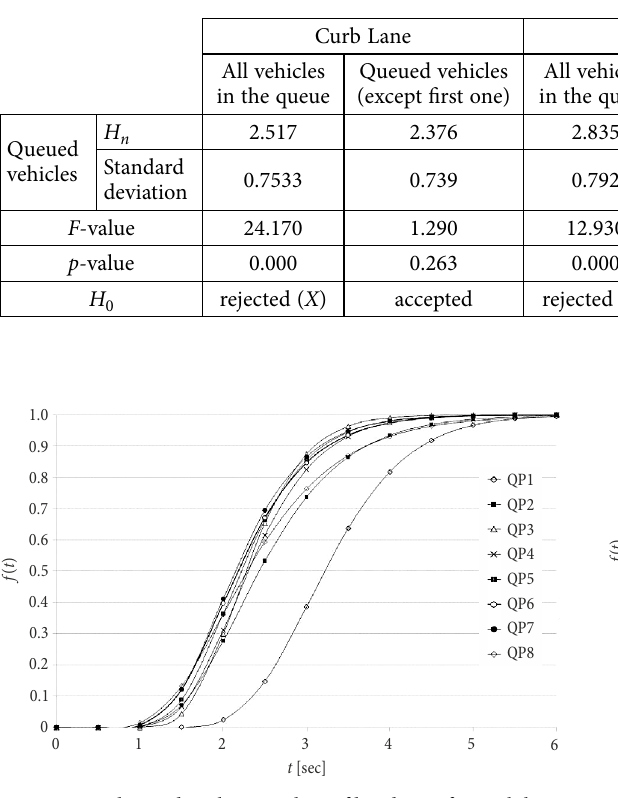
Fig. 1. Cumulative distribution plots of headways for curb lane Fig. 2. Cumulative distribution plots of headways for middle